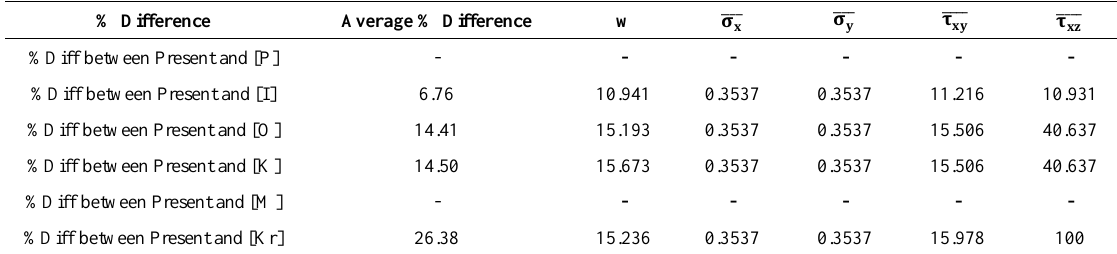
Table 6. Percentage difference summary of a rectangular square plate at varying span-depth ratio (a/t) from present and past studies.